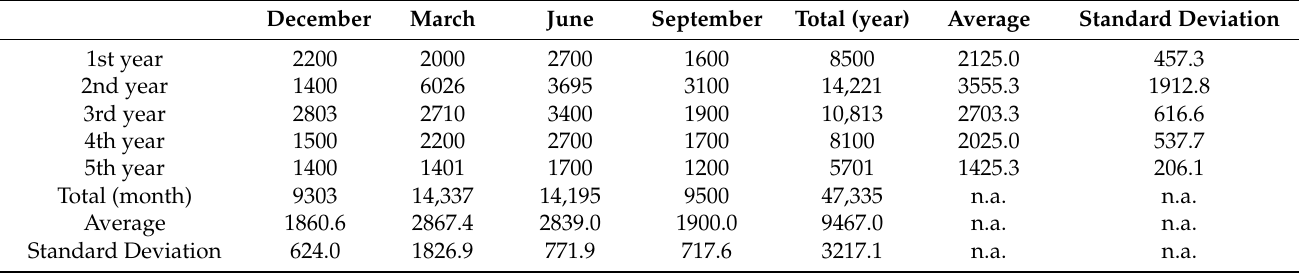
Table 5. Abundance of third-stage larvae of gastrointestinal parasites per month and per year of the study period.